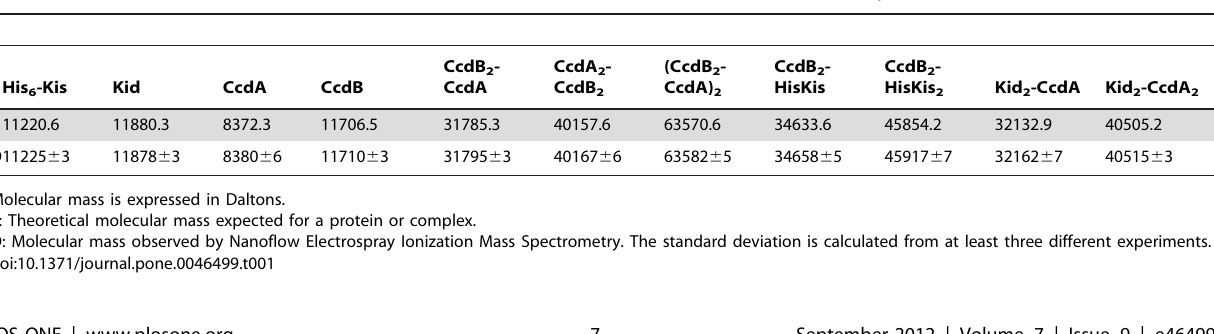
Table 1. Theoretical and observed molecular masses of the toxins, antitoxins and their complexes.